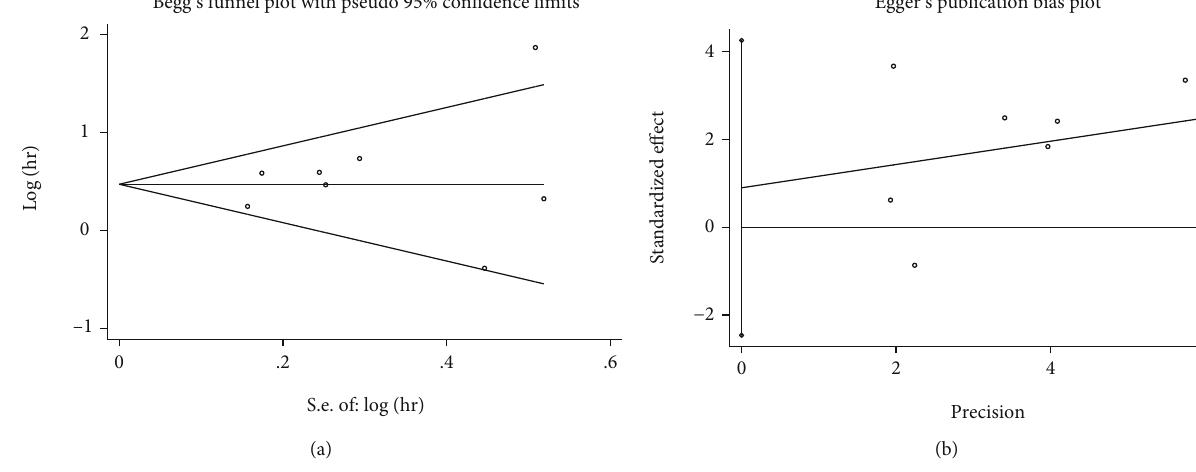
Figure 5: Result of publication bias. (a) Begg ’ s test; (b) Egger ’ s